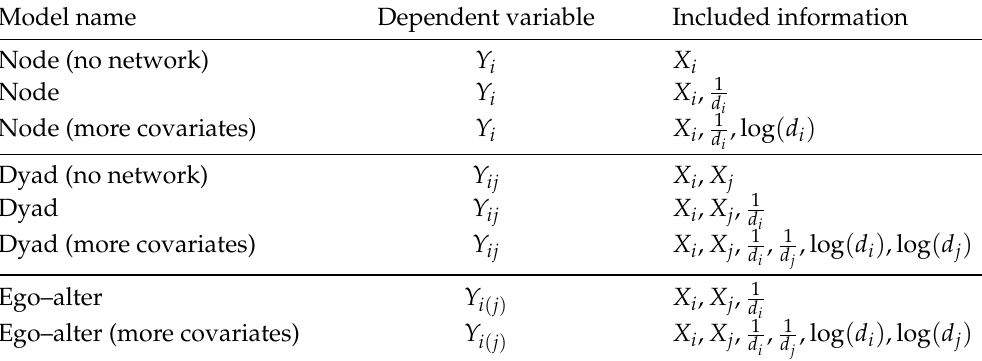
Table 1: Models evaluated.